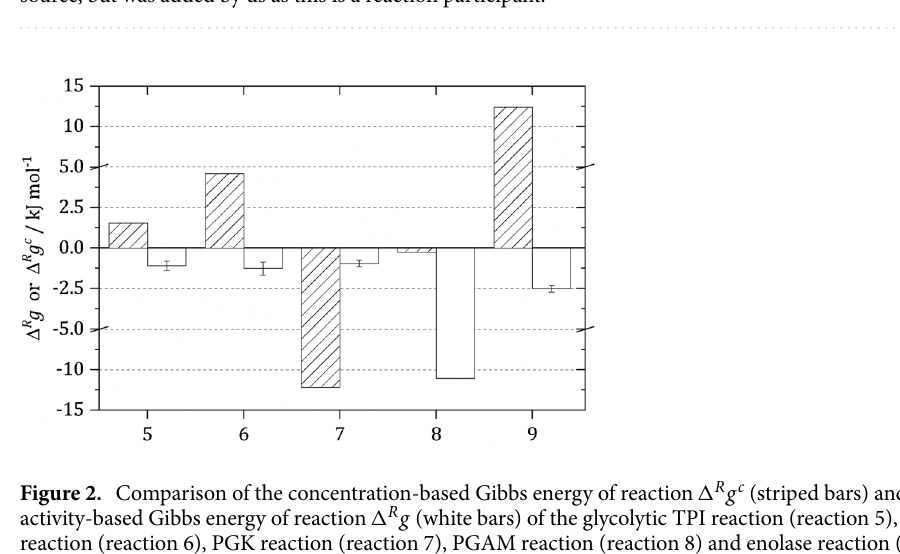
Figure 1. Comparison between the concentration-based standard Gibbs energy of reaction (cid:31) R g bars) 29 and the activity-based standard Gibbs energy of reaction (cid:31) R g reaction (5), GAPDH reaction (6), PGK reaction (7), PGAM reaction (8) and enolase reaction (9) at 298.15 K and pH 7.0 based on 12, 15, 22–24 . Please note that H + was not considered for GAPDH reaction in the original source, but was added by us as this is a reaction participant.